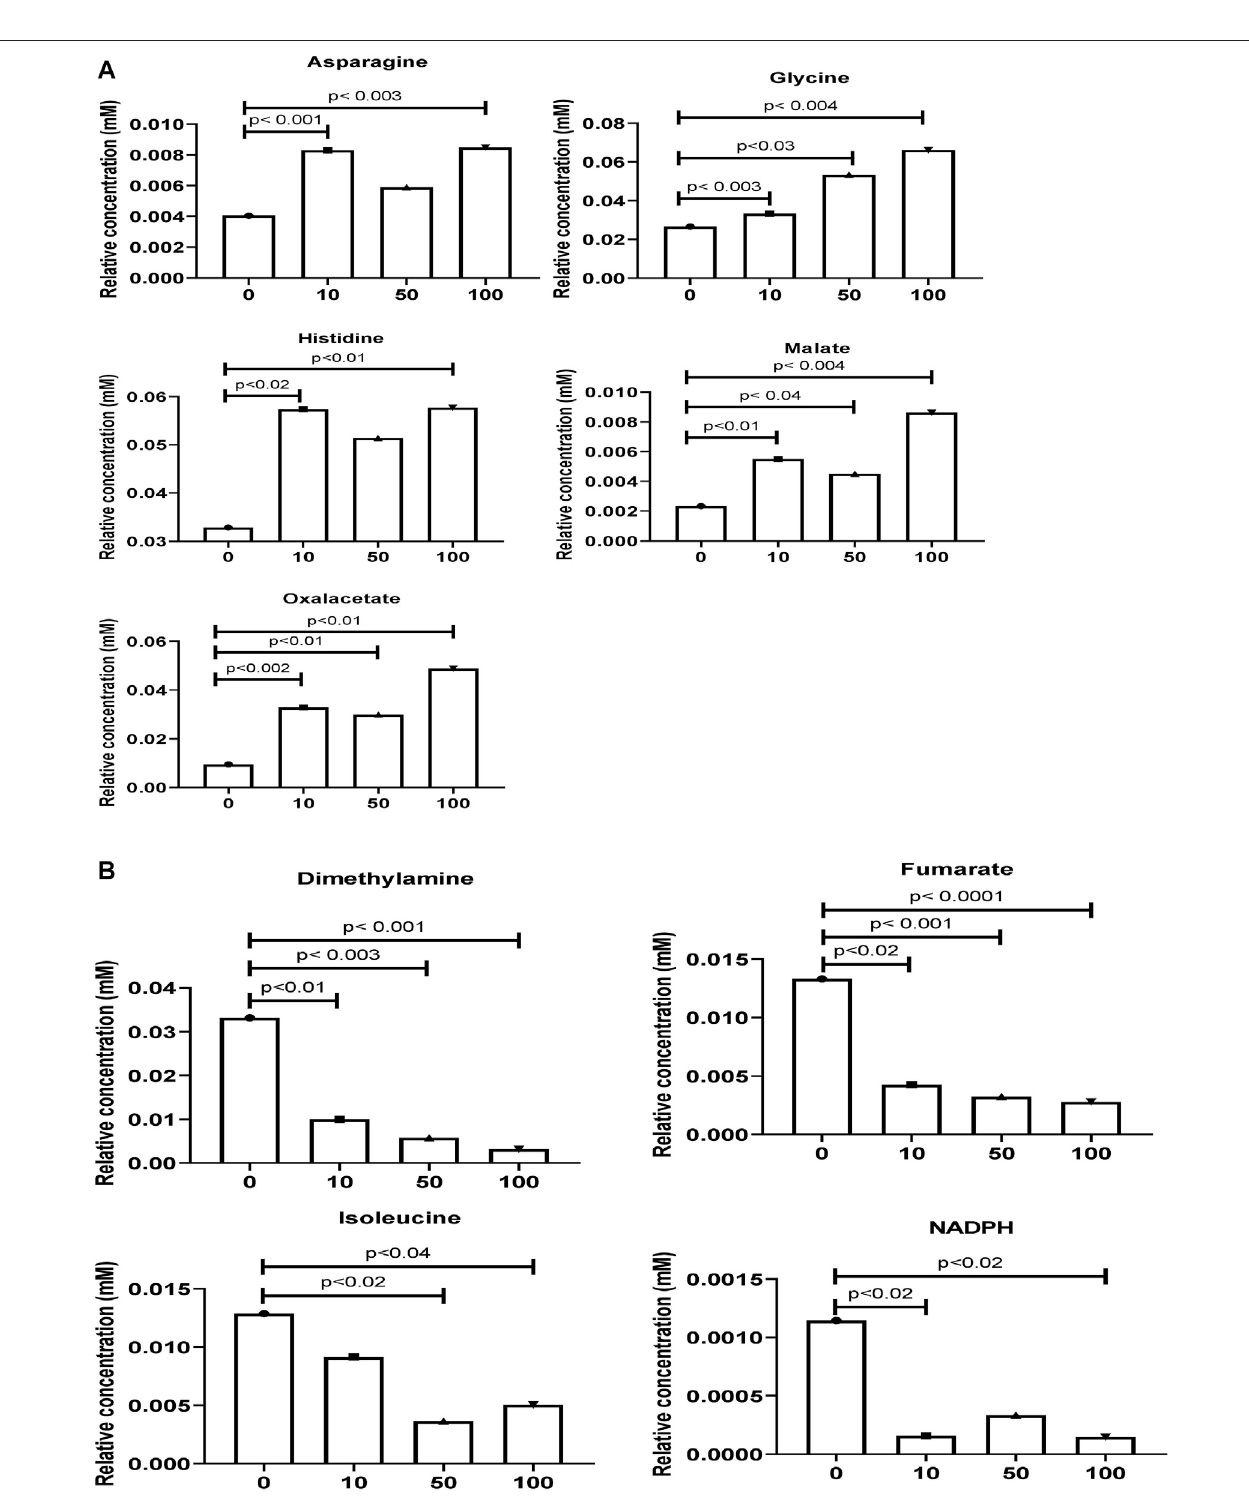
FIGURE3| ComparisonofthenormalizedrelativeintensitiesofthepotentialmetabolitesbetweencontrolandSWCNTappliedzebra fi sh (A) Theemployedstrategy of the automated assignment of metabolites, asparagine, glycine, histidine, malate, and an oxalacetate with signi fi cantly increased concentration from control samples and differences are shown. (B) The signi fi cantly decreased metabolites, dimethylamine, fumarate, isoleucine, and NADPH has been listed. t -test analysis; p < 0.05, p < 0.01, p < 0.001 are considered signi fi cant metabolites. Data show mean ± SEM.